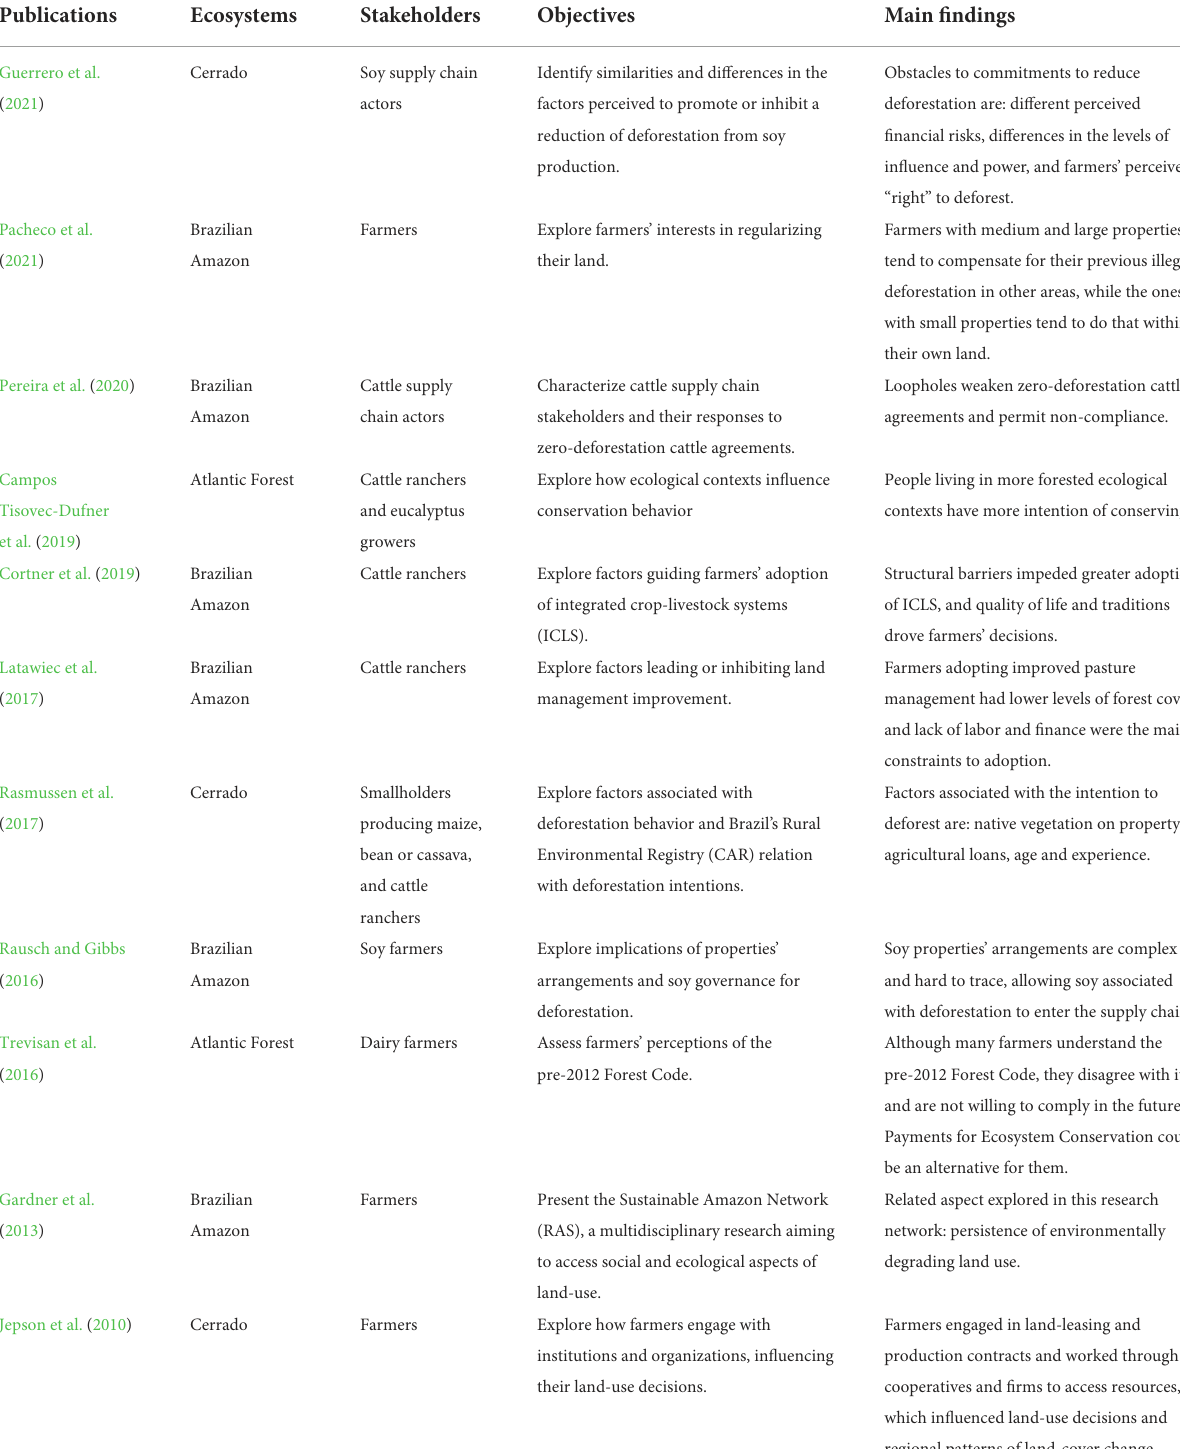
TABLE 1 List of studies exploring Brazilian farmers’ perceptions on land-use